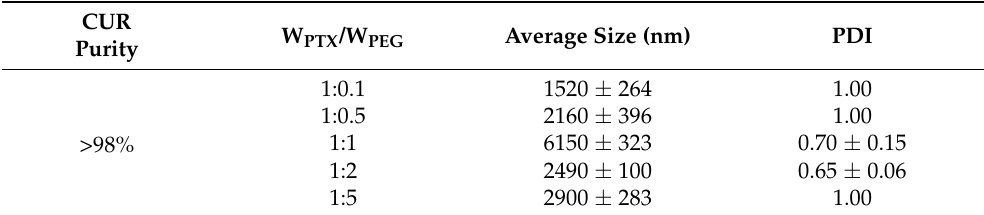
Table 2. The size and PDI of PTX-CUR NPs synthesized from PTX and high-purity CUR (>98%). PTX and CUR stand for paclitaxel and curcumin.